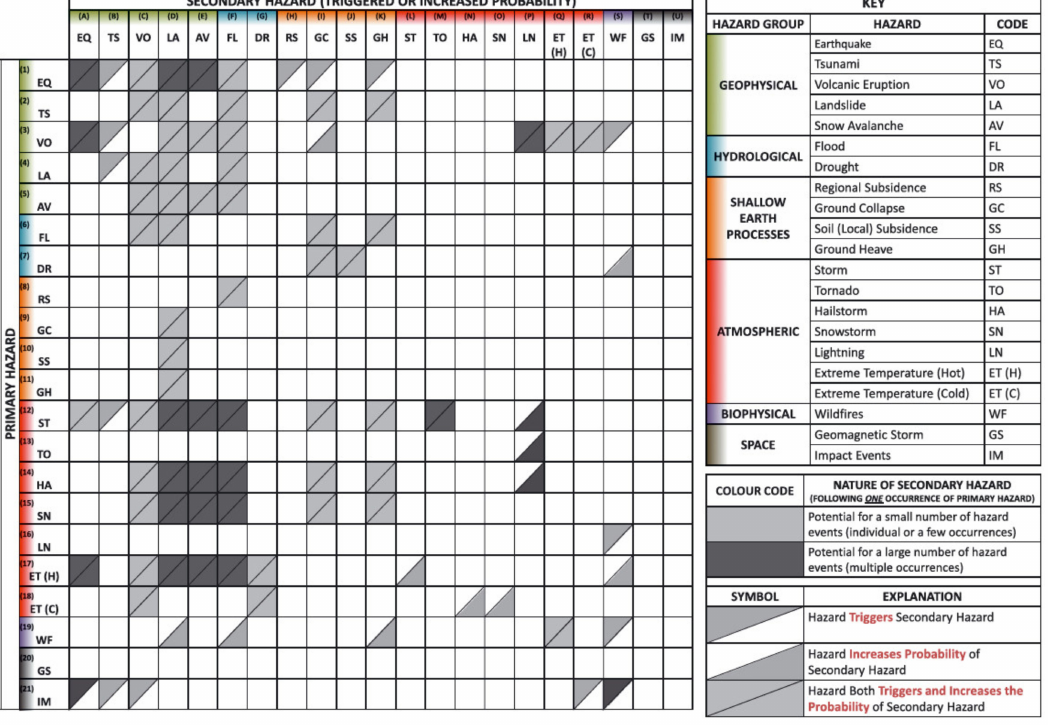
Figure 1. Identification of hazard interactions. Reproduced from “Reviewing and visualizing the interactions of natural hazards” by J. C. Gill and B. D. Malamud, 2014, Reviews of Geophysics, 52, p. 14. Copyright 2014 by the authors. Reproduced under the Creative Commons Attribution license